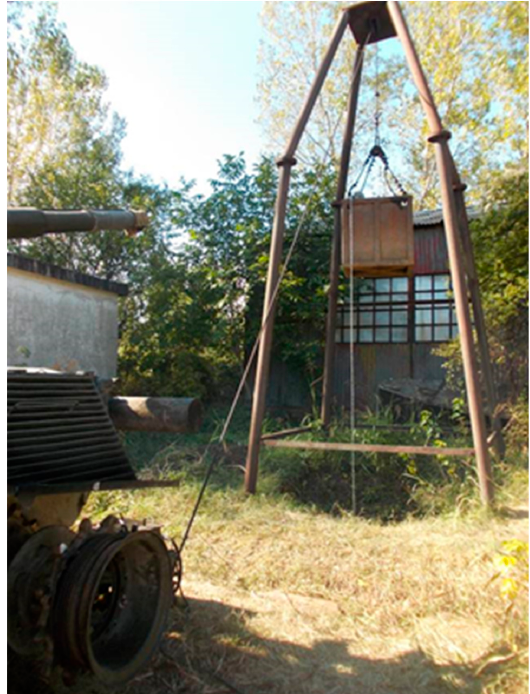
Figure 13. The experimental device used for determination of ( δ ).